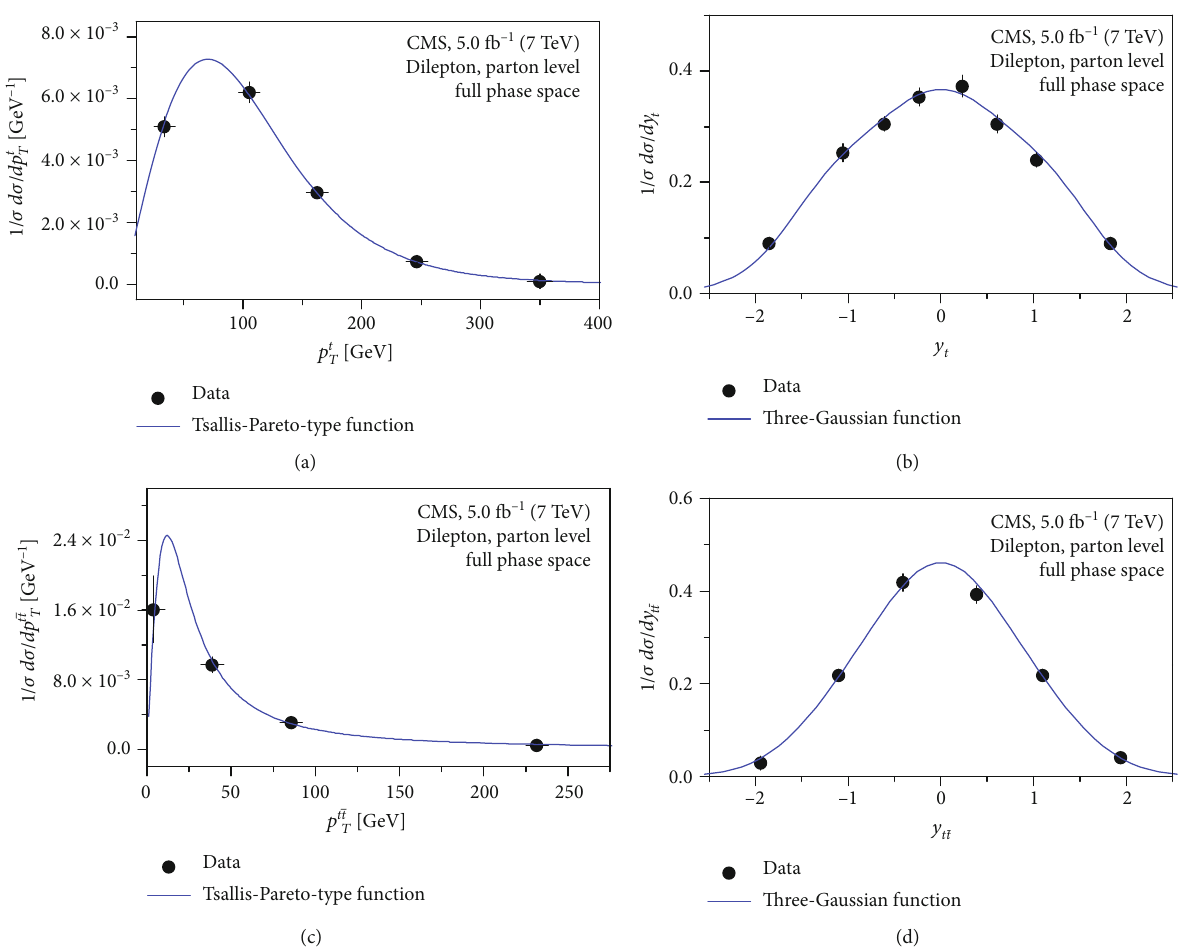
Figure 11: The same as Figures 1 and 2, but showing the results of t and t (cid:1) t produced in pp collisions at the parton level in the full phase space ffiffi p s = 7 at